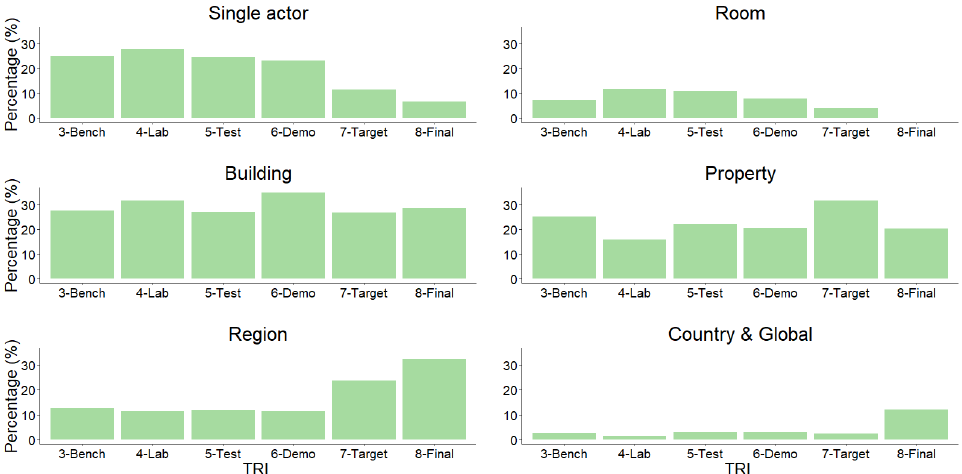
Figure 13. Deployment distribution between TRL and scale of the goal